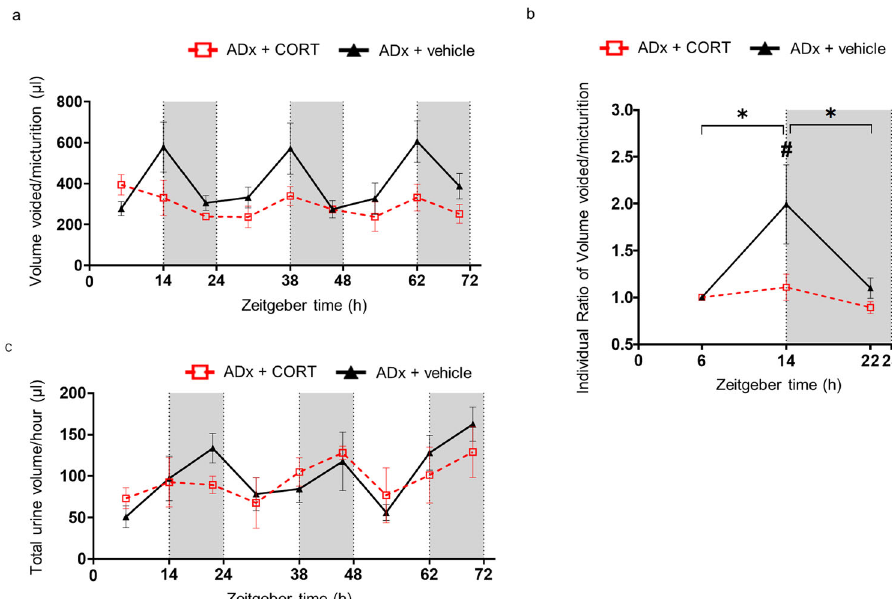
Fig. 6 The diurnal rhythm of micturition. a Volume voided per micturition per 8-h averages measured on 3 consecutive days in ADx + vehicle (solid black line) and ADx + CORT (dash red line). Each data series represents the mean ± SEM and 5 mice per time point. b Average of 3 days results of measured volume voided per micturition average per 8-h in ADx + vehicle (solid black line) and ADx + CORT (dash red line). Each data series represents the ratio of ZT14, 22 to ZT6 as 1 in the same and the mean ± SEM and 5 mice per time point. Differences were determined by two-way ANOVA and Sidak ’ s multiple comparisons test. # p < 0.01 v.s. ADx + vehicle and Dunnett ’ s multiple comparisons test. * p < 0.01 v.s. ZT 14 in ADx + vehicle and ADx + CORT. c Total voided volume per h per 8-h averages measured on 3 consecutive days in ADx + vehicle (solid line) and ADx + CORT (dash red line). Each data series represents the mean ± SEM and 5 mice per time point.